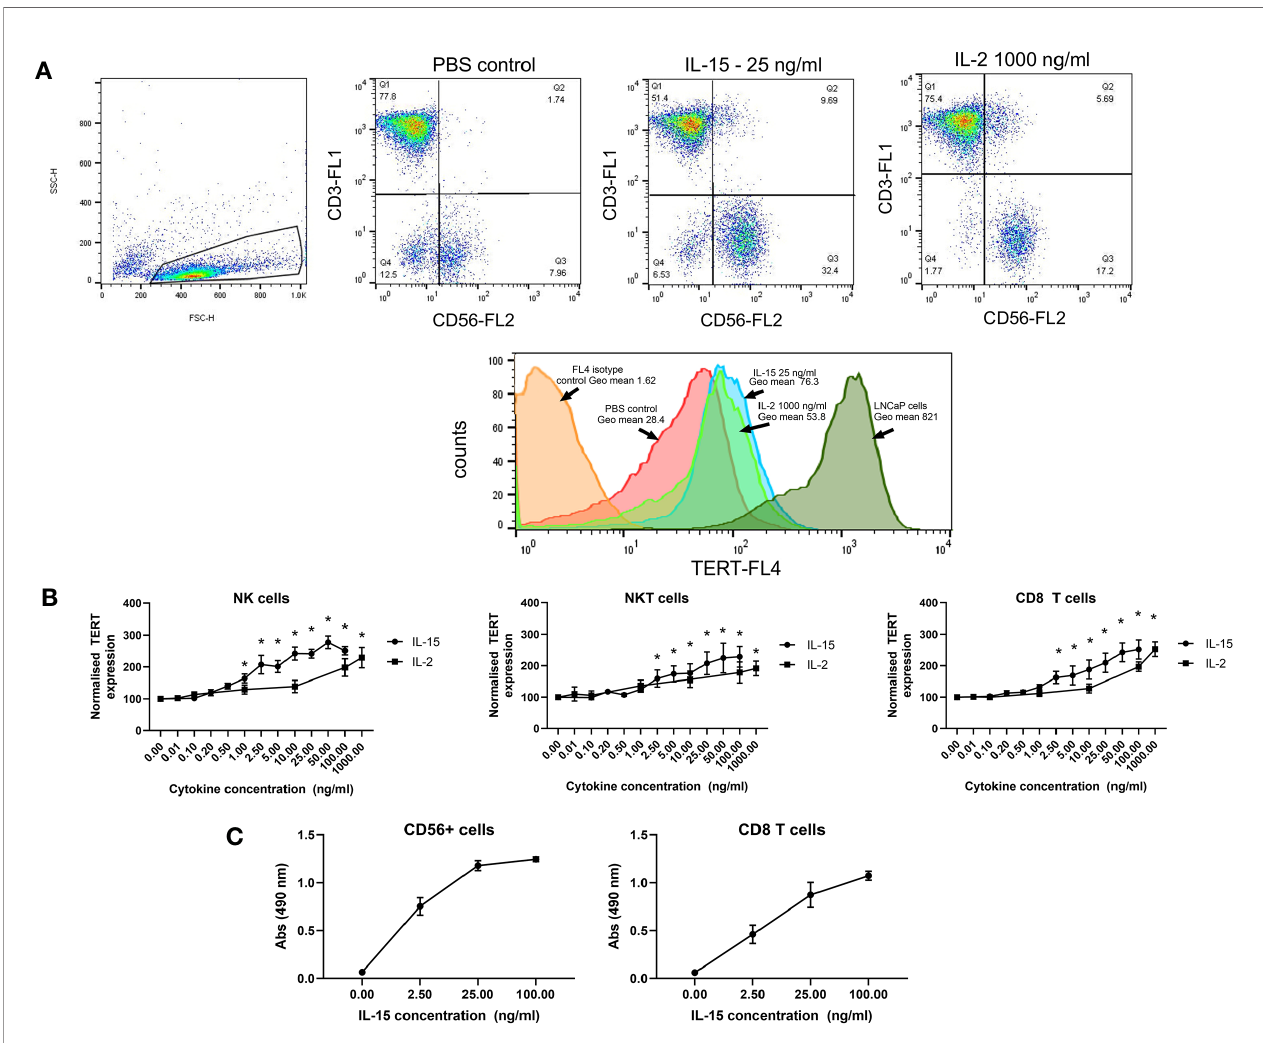
FIGURE 3 | Effects of IL-15 and IL-2 on the expression of TERT in NK, NKT, and CD8 T cells in non-adherent PBMCs after 7 days culture. (A) shows dot plots and histograms displaying TERT as detected by fl ow cytometric analysis using Alexa-Fluor647 conjugated anti-TERT antibodies. Cells were also stained with fl uorophore conjugated anti-CD8, anti-CD56, and anti-CD3 to distinguish the NK, NKT-like, and CD8 T cell populations. In (B) , results are expressed as the TERT geometric mean values from each experiment normalized to the PBS control. IL-15 induces signi fi cant increases in TERT in NK, NKT, and CD8 T cells starting at concentrations of 2.5 ng/ml. IL-2 also signi fi cantly increases TERT expression at concentrations from 100 ng/ml to 1000 ng/ml. Results represent means ± SEM from six separate experiments (six donors)(* p < 0.05 by one-way ANOVA and Newman Keuls post-hoc analysis). (C) shows telomerase activity in CD56 + and CD8+ T cells. measured via a TRAP assay after 7 days incubation with IL-15. Four concentrations of IL-15 were used: 0, 2.5, 25 and 100 ng/ml, with six repeats carried out. Results showed that as the concentration of IL-15 increased there was a rise in absorbance, indicating telomerase activity in the CD56+ and CD8 T